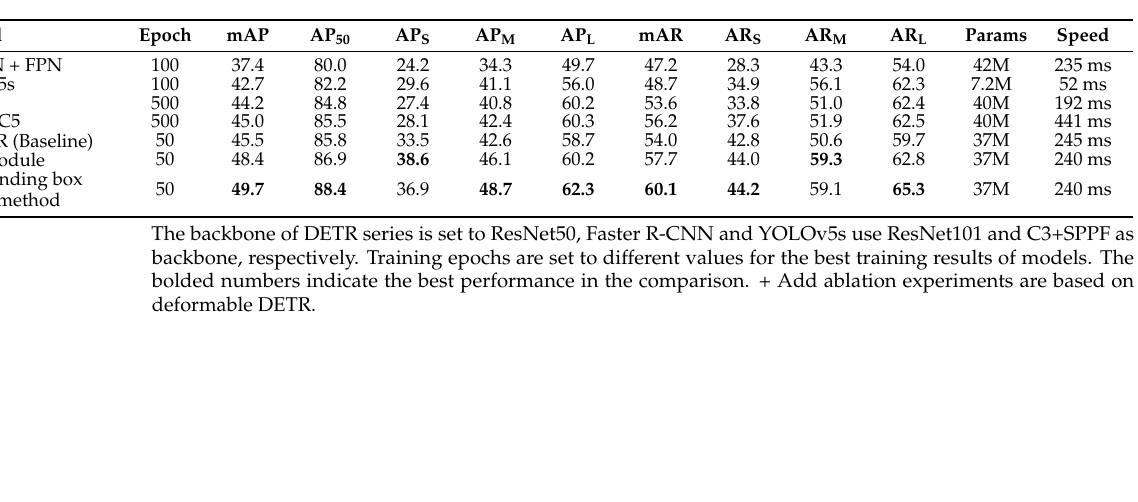
Table 3. Experimental results. Comparison of our improved model with other detection models on our FFS